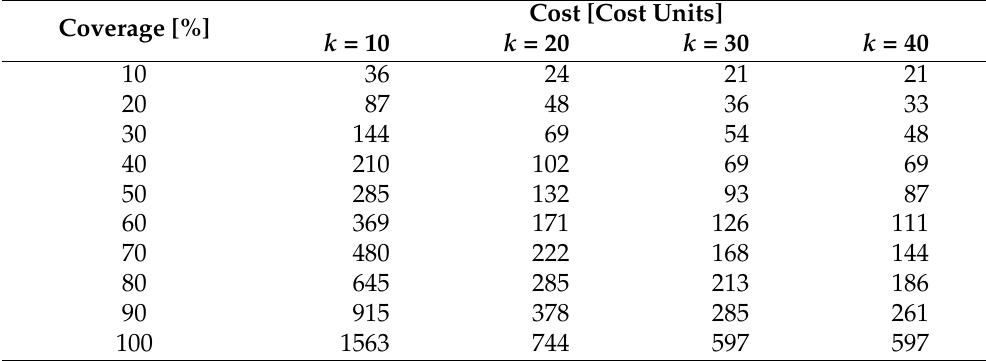
Figure 7. Optimal cost of IoT equipment deployment for the data set 1. Sampling frequency in a given pipe depends on flow and the size of the pipe. Table 6. Cost function values for the test scenarios of dataset